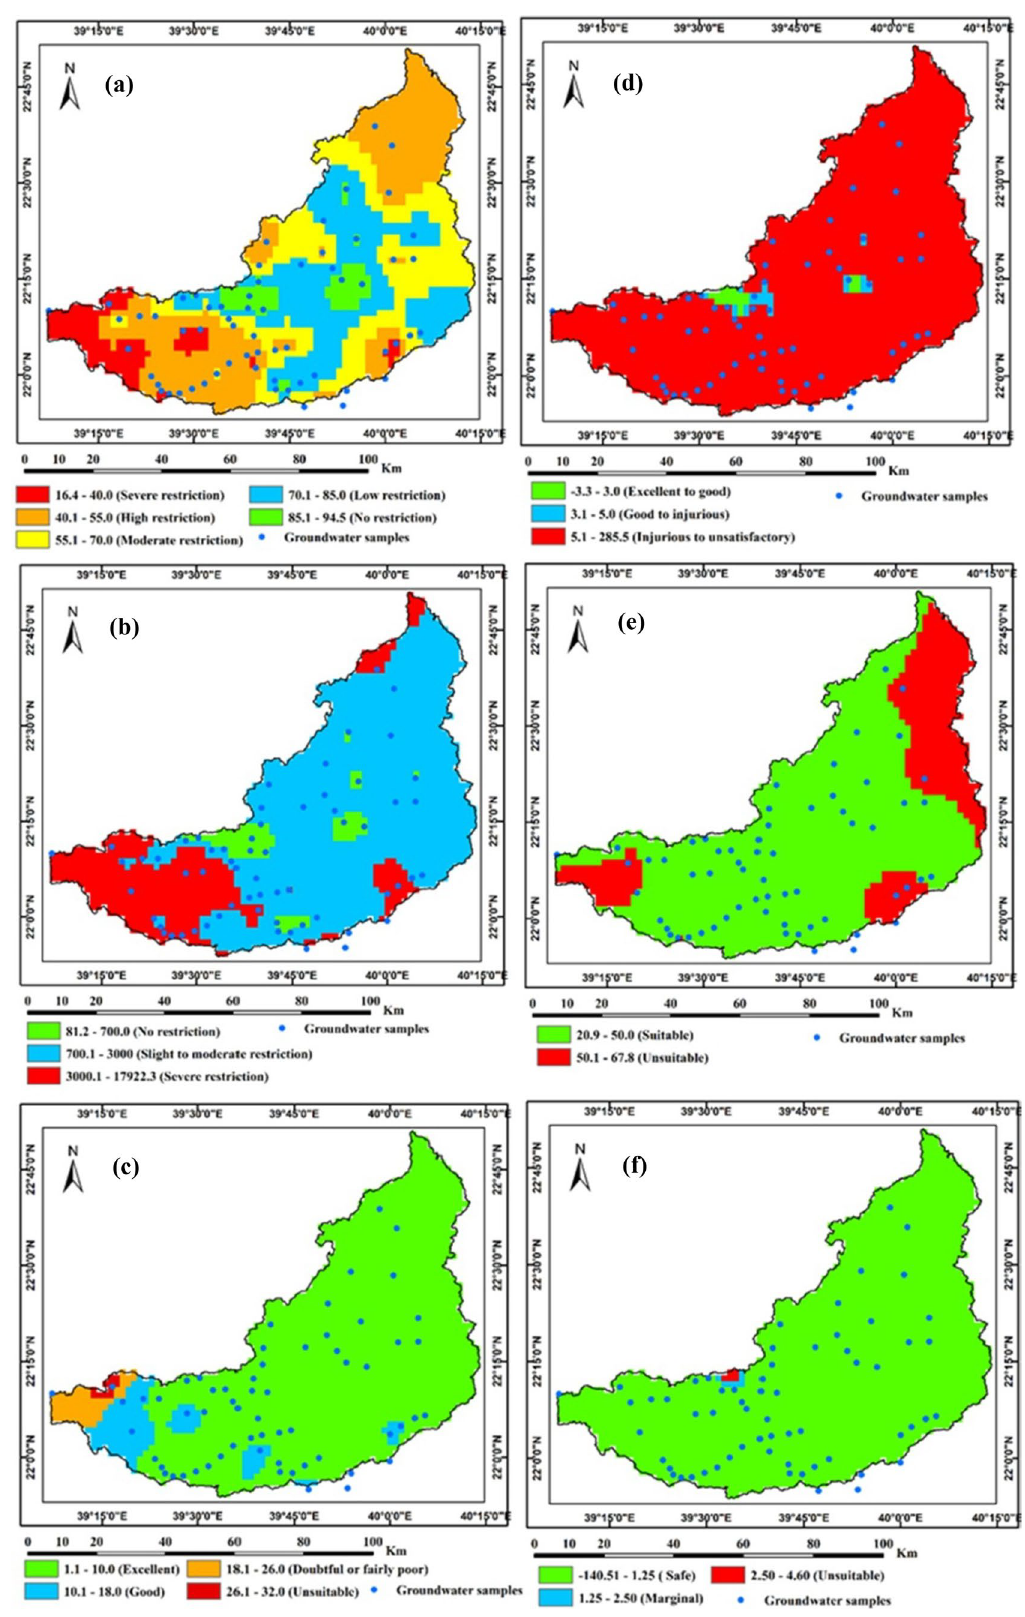
Fig. 10 Spatial distribution maps of IWQIs in Wadi Marawani basin: a IWQI, b TDS, c SAR, d PS, e MH, and f